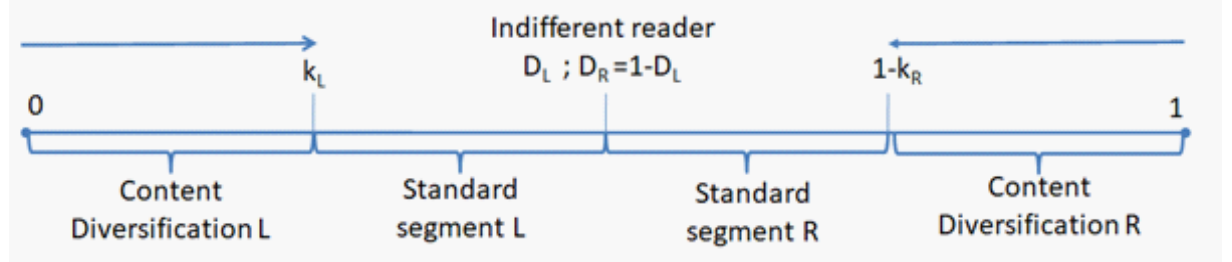
Figure 1: Content Diversi(cid:133)cation: Single-Homing Figure 1. Content Diversification: